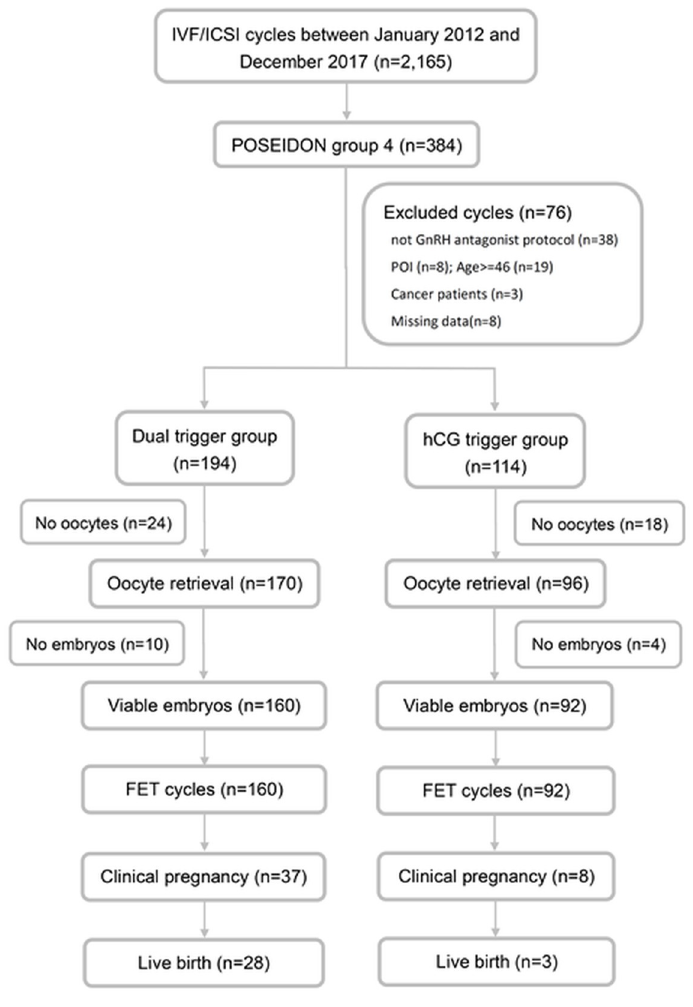
Fig 1. Flow chart of the study design. IVF, in vitro fertilization; ICSI, intracytoplasmic sperm injection; GnRH, gonadotropin-releasing hormone; POI, primary ovarian insufficiency; FET, frozen embryo transfer.